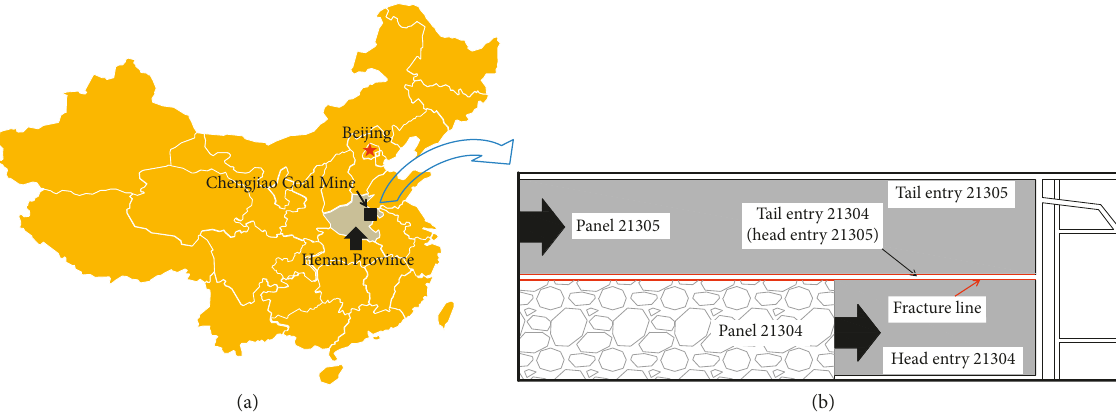
Figure 4: Geographical location and panel layout of the test site: (a) mine location; (b) layout of the 21304 and 21305 panels.